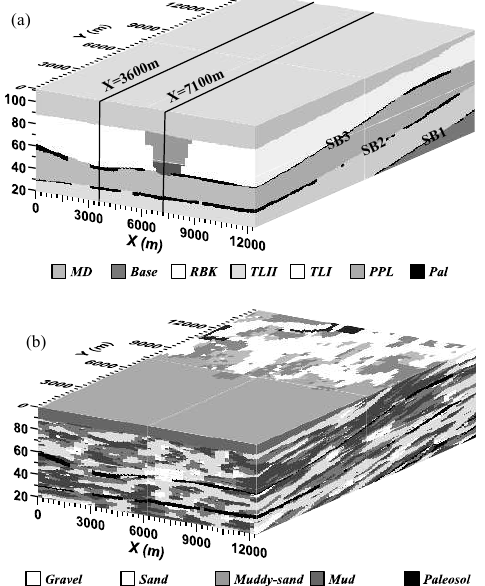
Figure 2. ( A ) Block diagram of sequence distributions in the study area. The SB1, SB2, and SB3 represent the first, second, and the third layer of sequence boundary paleosol. The rectangle within the IVF ( X = 7100 m) represents the vertical slice shown in Figure 4; and the rectangle outside of the IVF ( X = 3600m) represents the vertical slice shown in Figure 5. ( B ) The 3- d geological model of the study area.